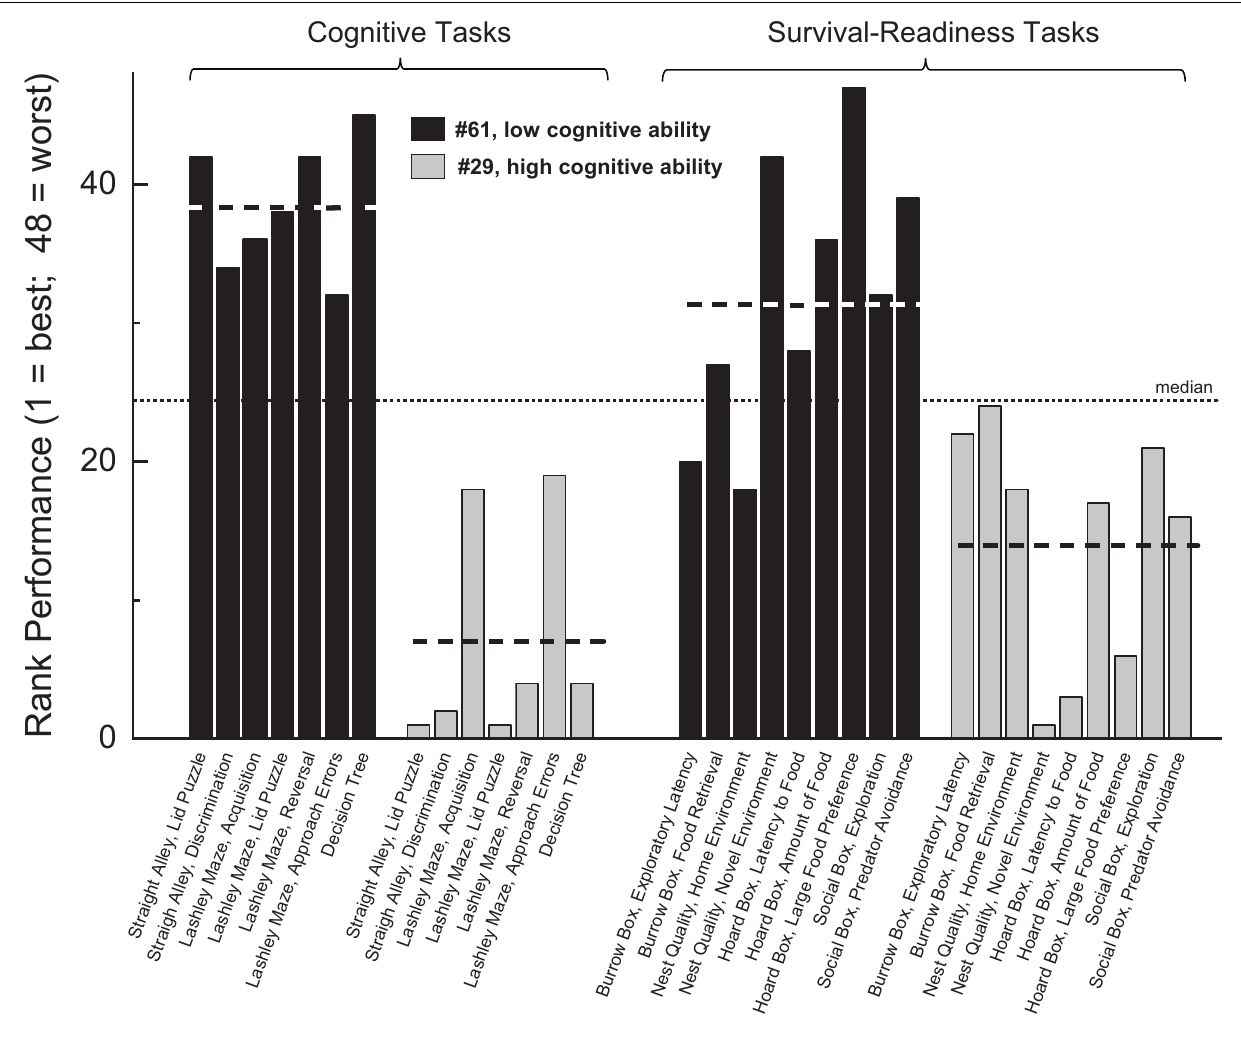
FIGURE 3 | Subject #29 (high general cognitive abilities, as determined by factor scores obtained from the PCA of cognitive tasks) and Subject #61 (low general cognitive abilities) were ranked relative to other animals in this sample ( n = 47) on each cognitive (left sets of bars) and survival-readiness task (right sets of bars). The heavy dashed line represents each animal’s mean rank on that set of tasks, and the light dashed line is the expected median for the sample of 47 animals. Subject #29 performed well above the median on each of the cognitive tasks, and also performed well on each of the survival readiness tasks. Subject #61 performed around the median or poorly on each class of